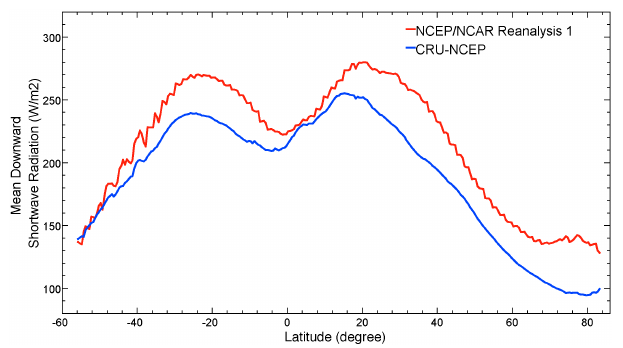
Figure 1. Comparison of the mean of long-term mean downward shortwave radiation (1948–2010) on land surface for each 0.5 de- gree latitudinal band from NCEP/NCAR Reanalysis 1 and CRU– NCEP data